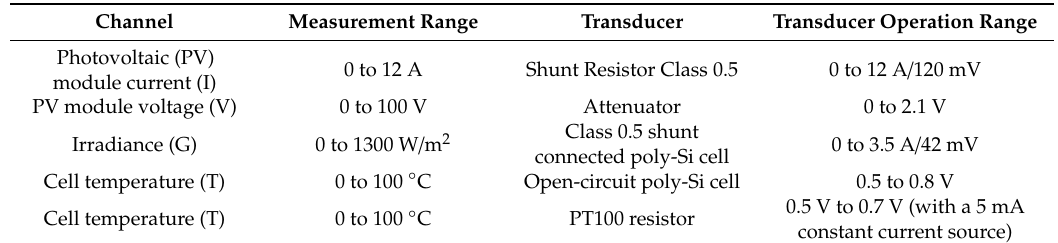
Table 2. Technical characteristics of the transducers used in the measurement of the variables.